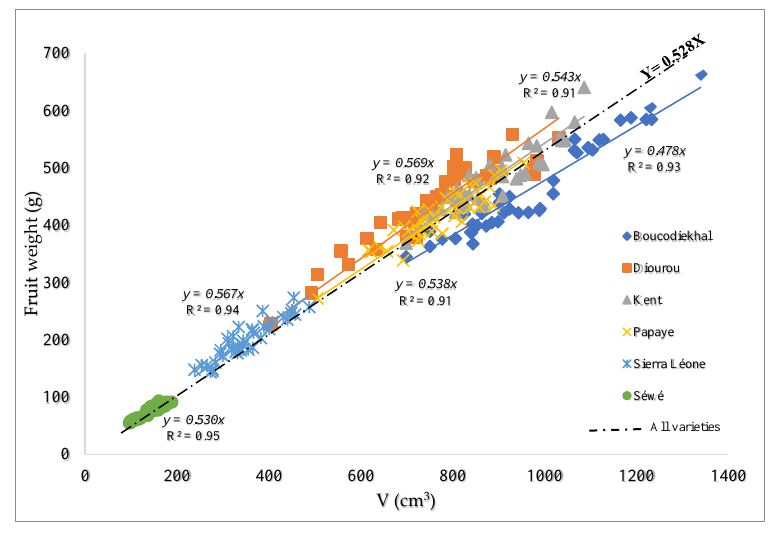
Figure 2. Correlation between the fruit weight and the equivalent volume V(cm 3 ) = L max × l max × e max . The line Y = 0.528X (R 2 = 0.96) is the linear regression on all observations of the scatterplot, all varieties combined ( n = 240). The lines y = C c .x are the linear regressions per variety ( n = 40).